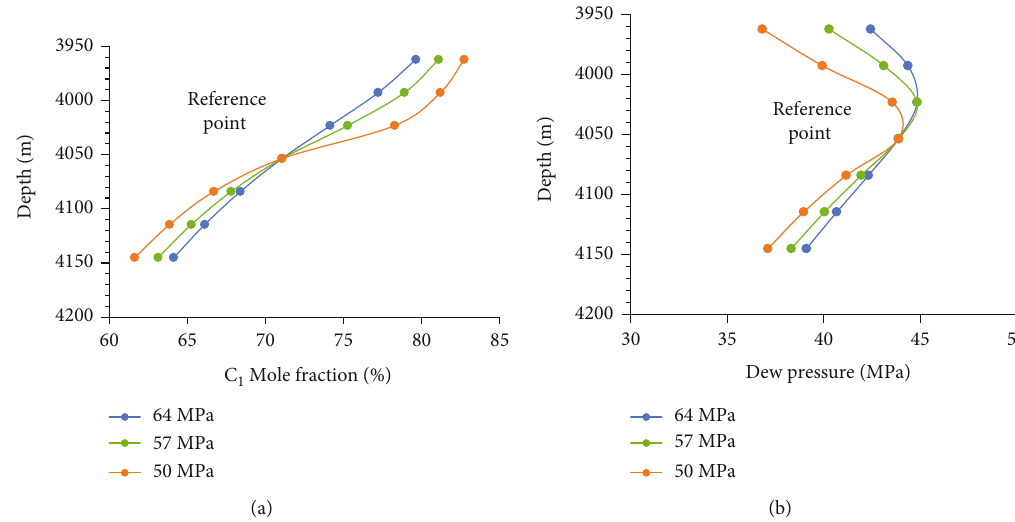
Figure 5: (a) E ff ect of reservoir pressure on compositional gradient. (b) E ff ect of reservoir pressure on dew point pressure of fl uid.